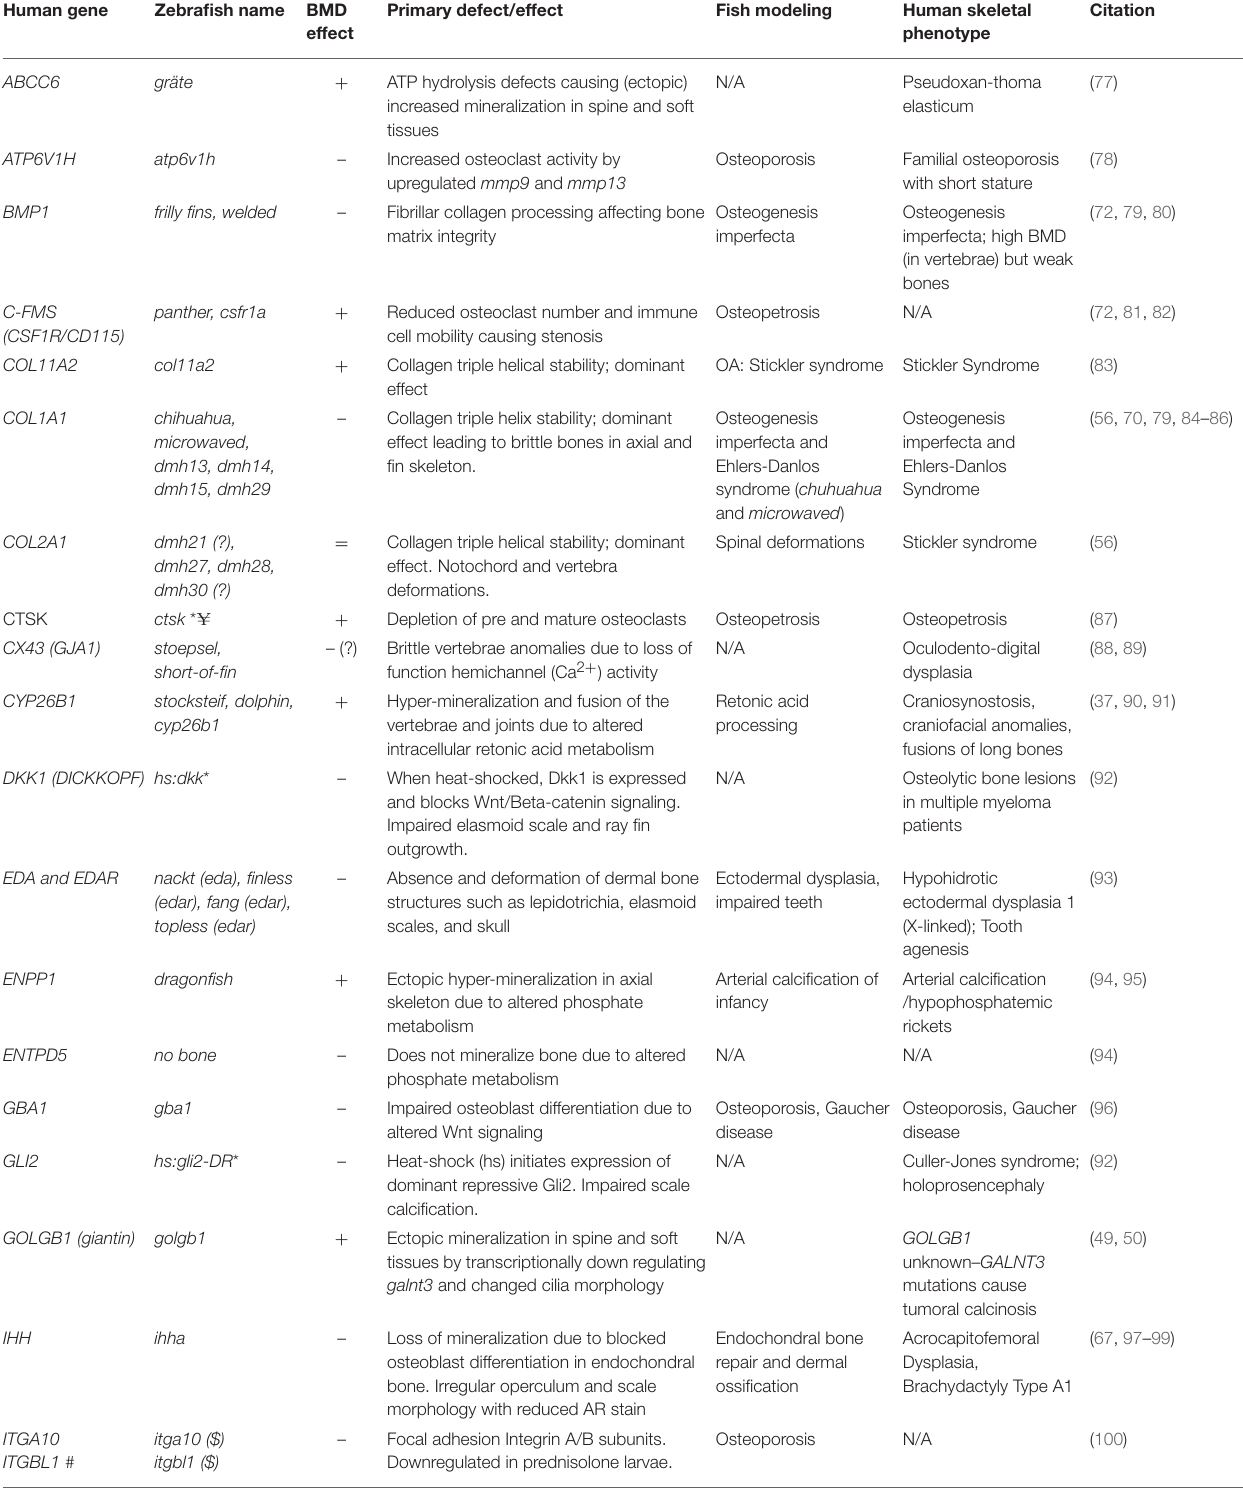
TABLE 2 | Zebrafish mutants, transgene insertion mutants, and morphants showing altered skeletal mineralization. Human